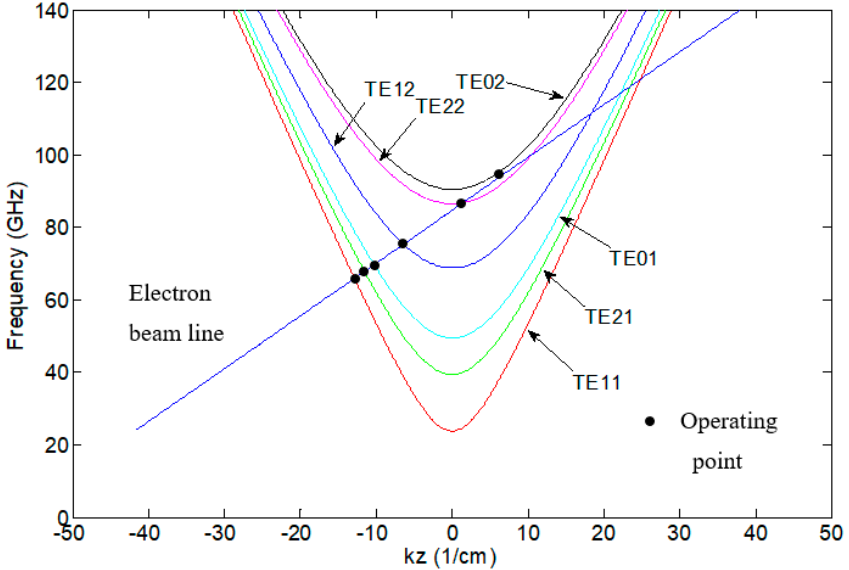
Figure 1. The dispersion diagram of the TE 02 mode and the possible oscillating modes ( U = 70 kV, α = 1.2, B / B g = 1.026, and r w = 3.7 mm). According to the observations from the previous experiment for the W-band TE 01 mode gyro-TWT, in order to suppress these competing modes, a periodic dielectric loaded circuit (shown in Figure 2) has been applied, in which the relative permittivity and the loss tangent of the dielectric, the periodicity, and the dimension of the circuit have been optimized for the highest efficiency.